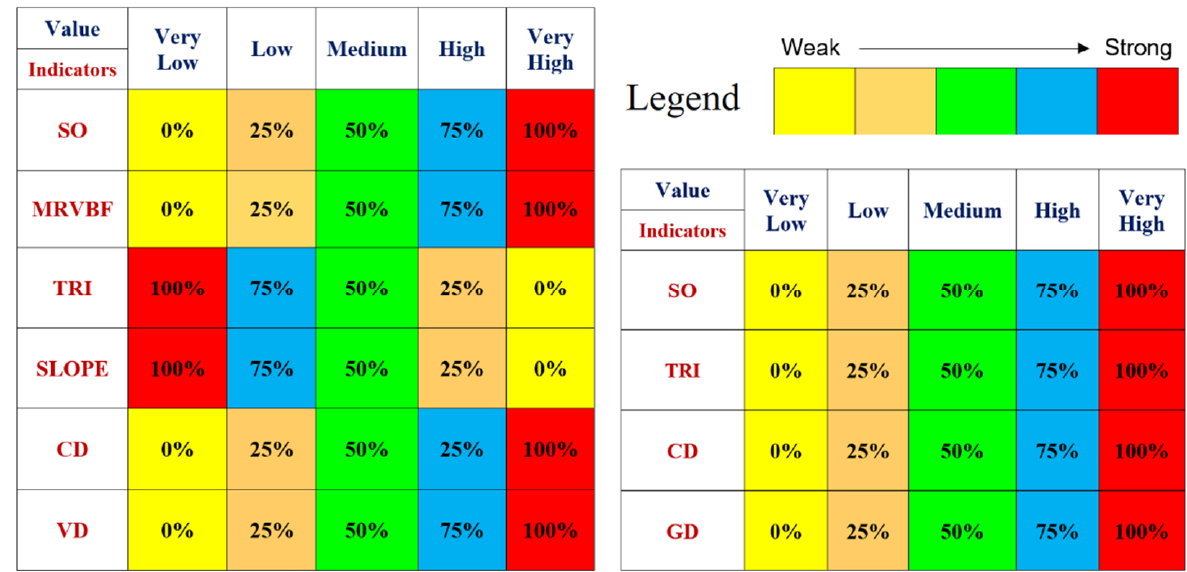
Figure 2. Indicators with suitability relation, Reservoir (left), and Dam Wall (right). The average extracted values of each indicator further analyzed using the simple additive weighting (SAW) technique for final decision making of storage structures. The technique solves the weighted performance of each indicator for individual box unit. SAW requires a normalization process either performed as a decision matrix or on the actual values. In this study, SAW technique was modified and performed on actual values of each indicator. The weight factor in SAW technique is divided into Inter weights (weights assigned to different indicators) and intra-weights (weights assigned to value/box units